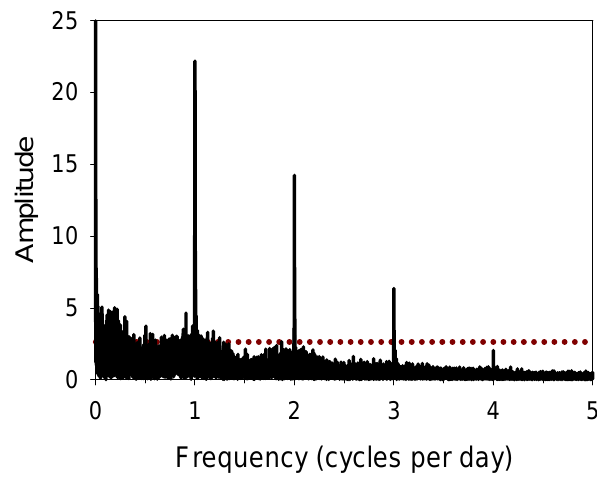
Figure 11: FFT spectrum of a long (11-year) interval at Roded site showing frequencies of 1- , Fig. 11. FFT spectrum of a long (11-year) interval at Roded site 2- and 3 cycles per day corresponding to the diurnal S1, S2 and S3 periodicities. Sampling rate showing frequencies of 1-, 2- and 3 cycles per day corresponding to is 15 minutes and data gaps are filled by linear interpolation. the diurnal S1, S2 and S3 periodicities. Sampling rate is 15min and data gaps are filled by linear